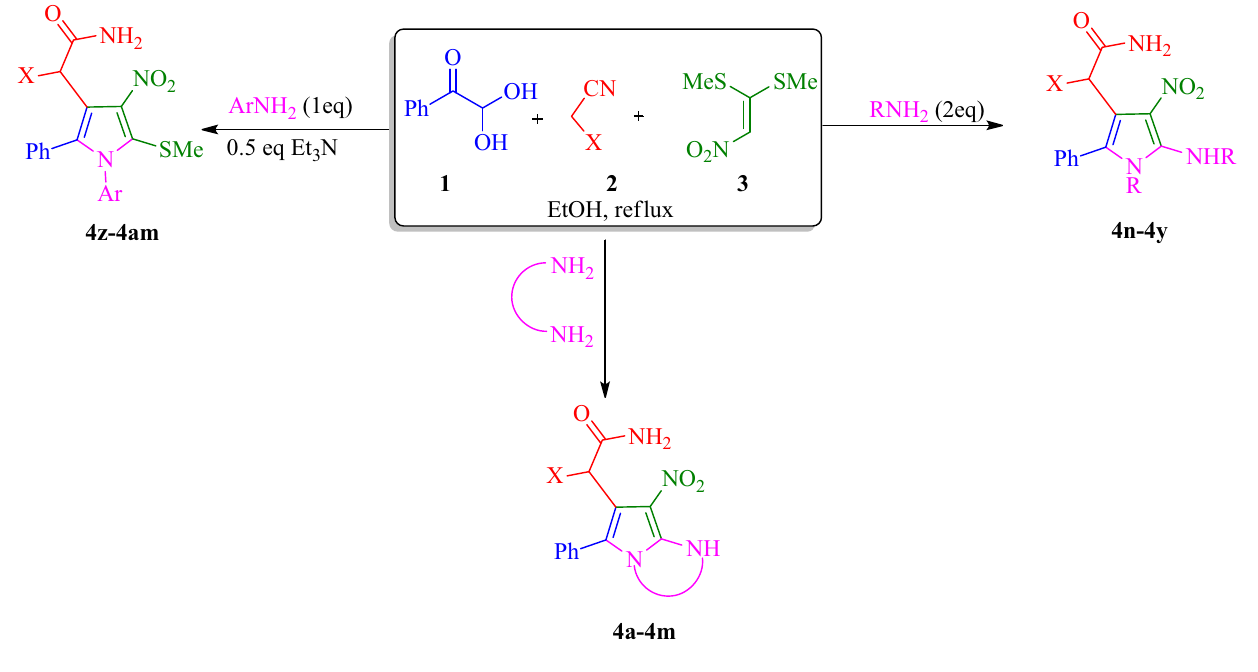
Figure 4. Synthesis of polysubstituted pyrroles 4a-4am